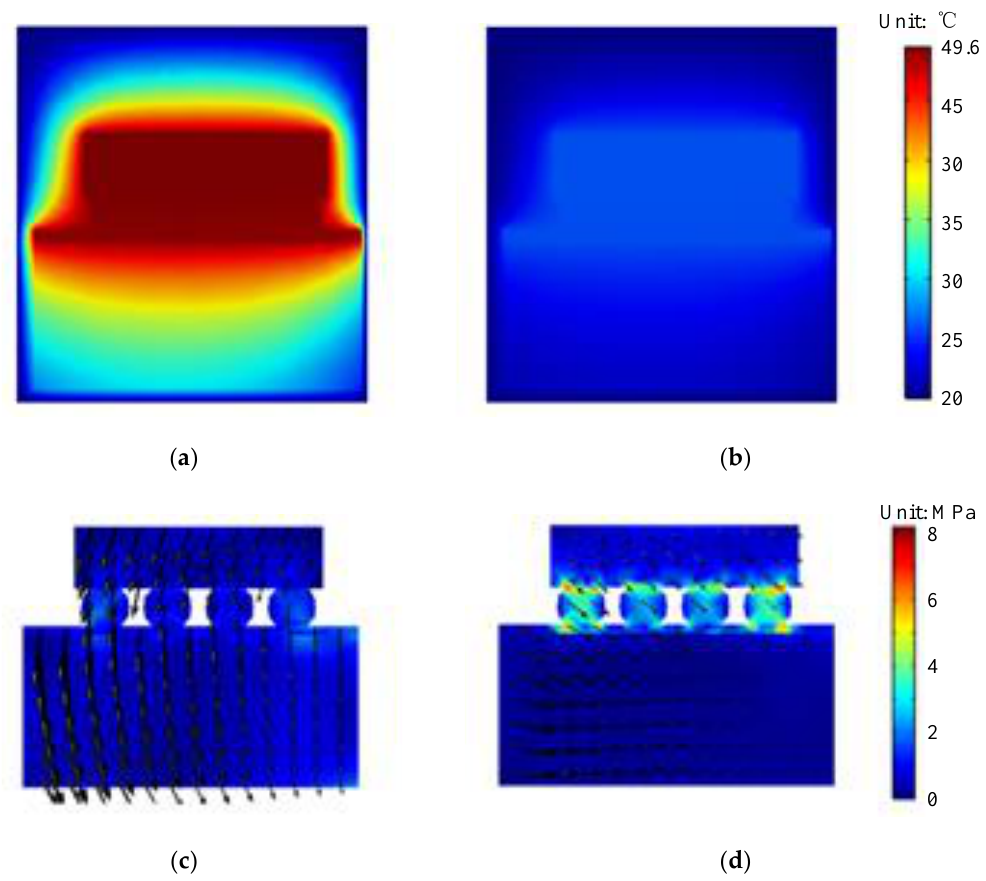
Figure 8. Temperature and stress distribution of the flip chip component at the vertical section of key solder point: ( a ) temperature distribution in the high power dissipation period ( t = 4.11 h); ( b ) temperature distribution in the low power dissipation period ( t = 6.11 h); ( c ) stress distribution in the high power dissipation period ( t = 4.11 h); and ( d ) stress distribution in the low power dissipation period ( t = 6.11 h).